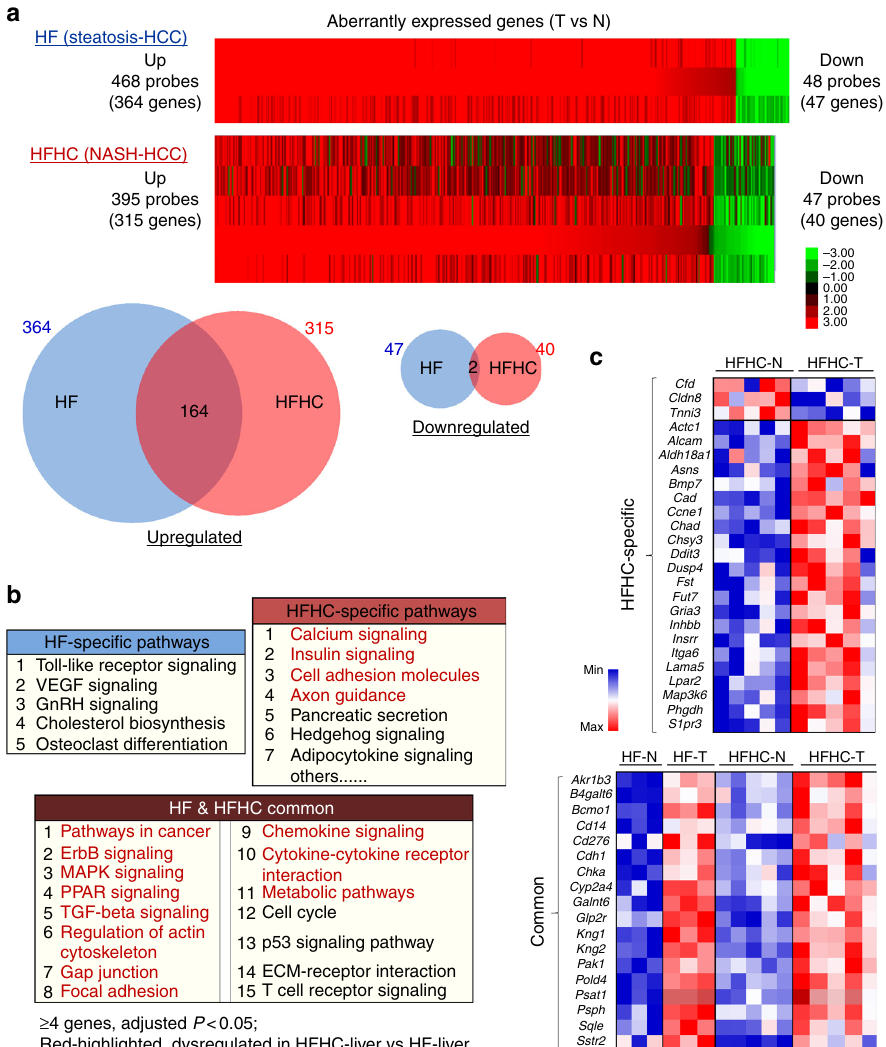
Fig. 3 Aberrant gene expression and the dysregulated pathways in HCCs from HF- and HFHC-fed mice. a Heat map of differentially expressed genes in HCCs versus adjacent non-tumorous samples in HF- and HFHC-fed mice. With the majority in both groups upregulated, the two groups shared about half of the upregulated genes. b Pathways dysregulated commonly in both HFHC-associated NASH-HCCs and HF-associated steatosis-HCCs, or speci fi cally in one group, by aberrant gene expression ( ≥ 4 genes involved, P < 0.05 by multiple test adjustment) are shown. Pathways highlighted in red were also dysregulated in NASH versus steatosis. c Differentially expressed genes in HCCs compared to adjacent non-tumorous livers (upper panel, unique in HFHC- fed mice; lower panel, common in both groups). Expression levels were normalized to the mean level of each gene among all samples